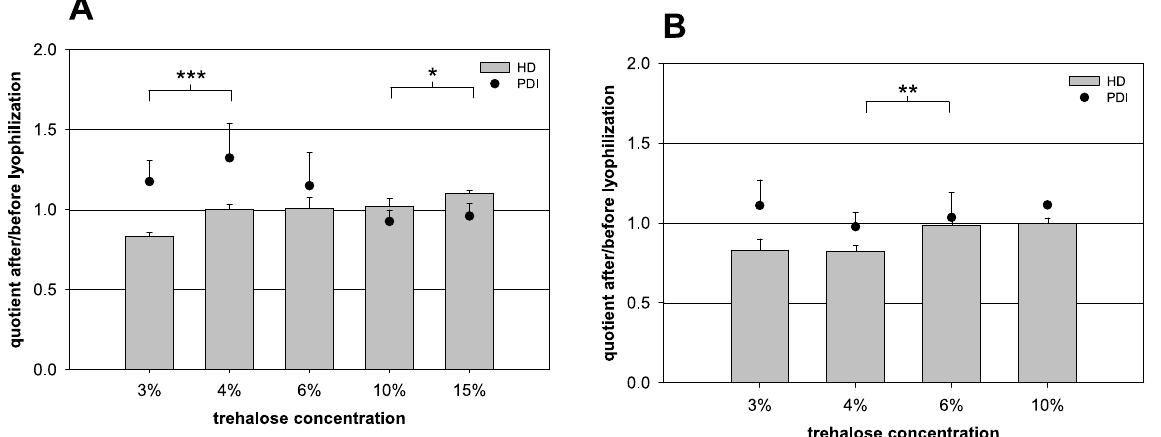
Figure 4. Influence of the lyophilization on the quotient of the hydrodynamic diameter (HD, bars) and the quotient of the polydispersity index (PDI, dots) before and after lyophilization, respectively. ( A ) 100 µL nanocapsule suspension + 900 µL purified water with various amounts of trehalose and ( B ) 1000 µL nanocapsule suspension with various amounts of trehalose (statistical test: two-tailed Student’s t -test; * for p ≤ 0.05, ** for p ≤ 0.01, *** for p ≤ 0.001; mean ± SD; n = 3).